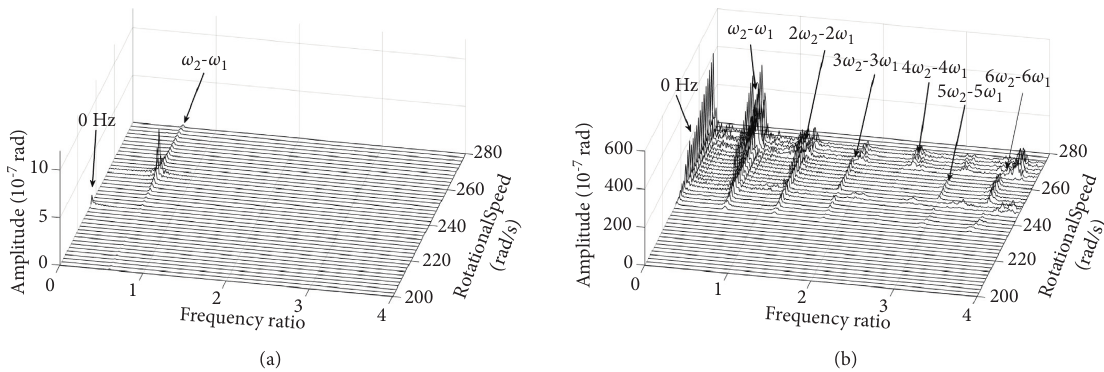
Figure 14: Waterfall spectrum plots for the torsional vibration of disk 4 during level flight. (a) Without rub-impact. (b)